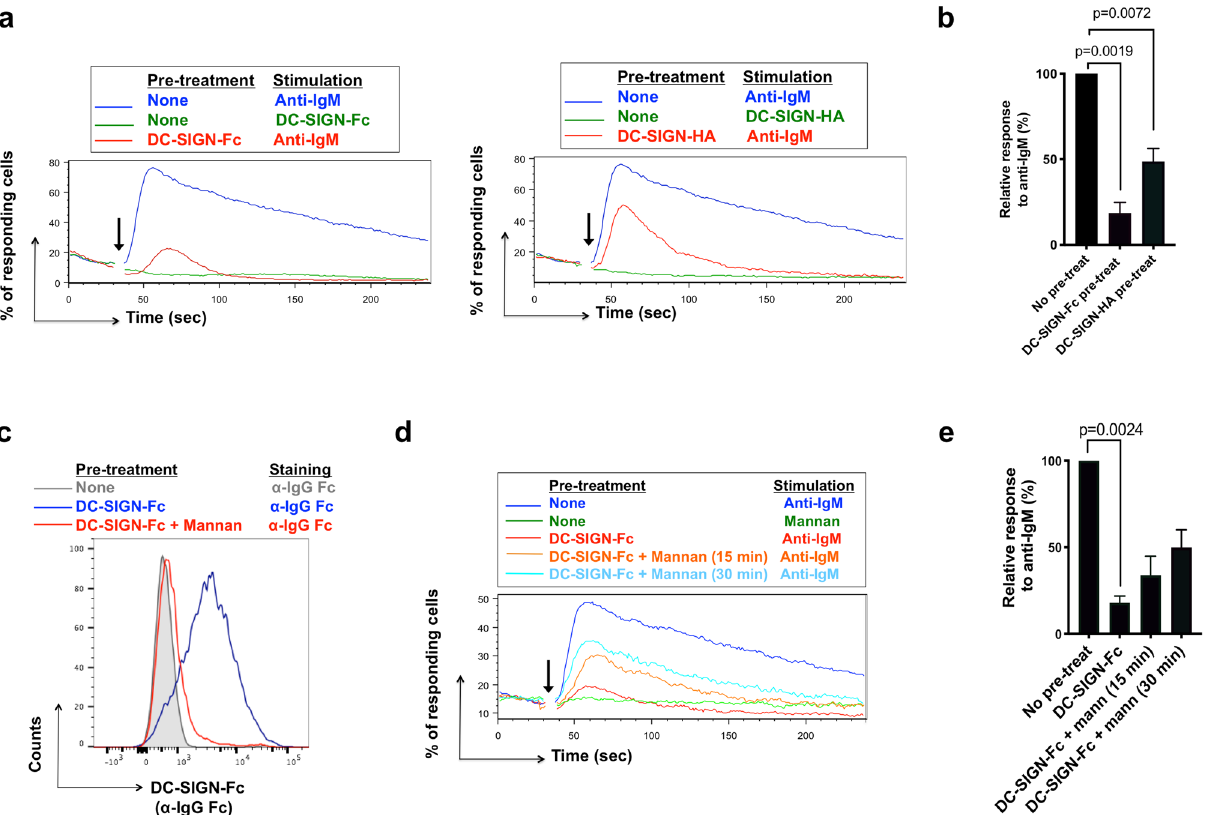
Figure 4. Effect of DC-SIGN pre-exposure on anti-IgM-induced signaling in WSU-FSCCL cells. ( a , b ) Anti- IgM-induced iCa 2+ flux in WSU-FSCCL cells following pre-exposure to DC-SIGN-Fc/HA. ( a ) Representative results for DC-SIGN-Fc (left) and DC-SIGN-HA (right) pre-treatment follow by addition (arrow) of the stimulation as stated and ( b ) summary of data mean for 6 (DC-SIGN-Fc) or 3 (DC-SIGN-HA) individual experiments. Graphs show mean (± SD) response with values for anti-IgM only cells set to 100%. Statistical significance of the indicated differences is shown (paired t-test). ( c ) DC-SIGN displacement after mannan incubation. FACS analysis of WSU-FSCCL cells left untreated (grey), incubated with DC-SIGN-Fc 30 min at 37 °C (blue) or incubated with DC-SIGN-Fc 30 min at 37 °C, washed and left 15 min with 40 μg/ml of Mannan at 37 °C (red). Cells were stained with APC Cy-7 F(ab’) 2 anti-hIgG Fc (α-IgG Fc) to detect DC-SIGN-Fc binding. ( d , e ) Effect of pre-treatment with DC-SIGN-Fc ± mannan for 15 or 30 min at 37 °C on iCa 2+ flux. ( d ) Representative result and ( e ) summary of data mean for 3 individual experiments. Graphs show mean (± SD) response with values for anti-IgM only/no pretreatment cells set to 100%. Statistical significance of the indicated differences is shown (paired